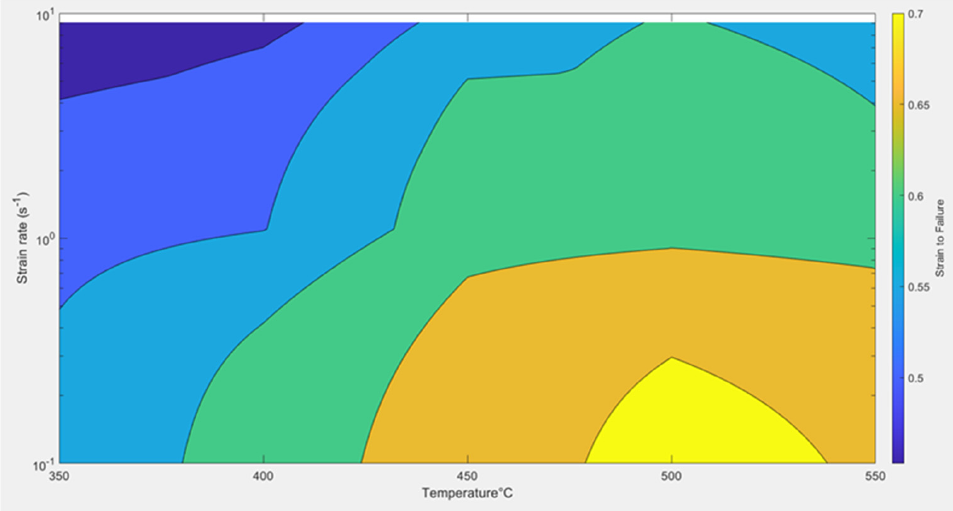
Figure 4. Strain to failure, strain rate, temperature forming parameter map.